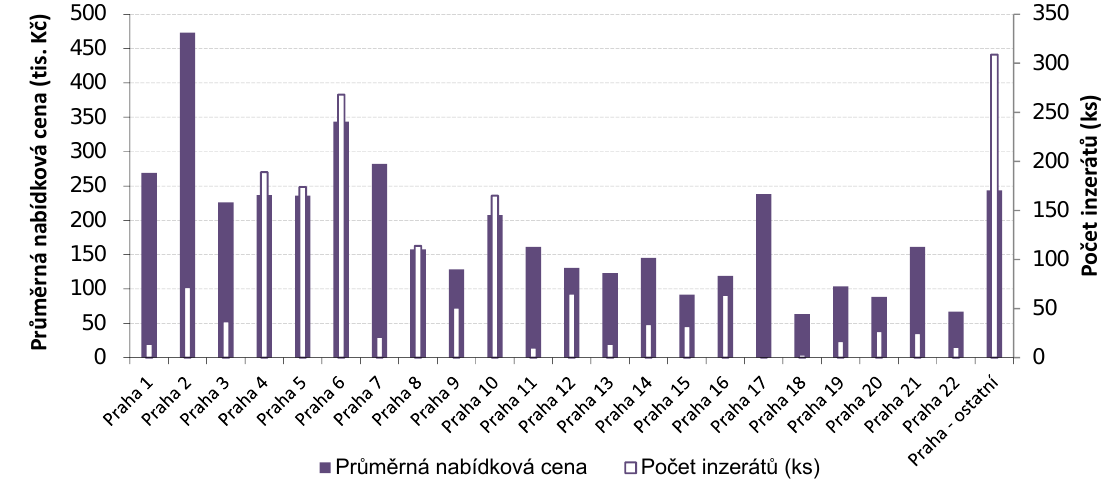
Obrázek 9: Průměrná nabídková cena rodinného domu v období 1920-1944 dle městských částí Prahy. Průměrná cena rodinného domu v Praze v období 1920-1944 byla 233 460 Kč. Mezi tzv. „nejdražší“ lokality v Praze patřila Praha 2, 6 a 7. Je zajímavé, že mezi nejdražší lokality patřila Praha 7, která dříve byla převážně průmyslovou lokalitou. Částečně tuto vysokou nabídkovou cenu lze přiřadit nízkému počtu záznamů a tedy zkreslení průměrné nabídkové ceně, avšak medián je blízký hodnotě průměrné nabídkové